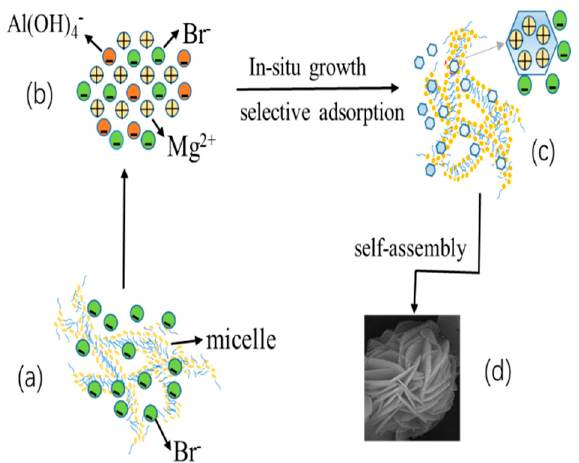
Figure 3. The formation process of hierarchical hydrotalcite ( a ) represents the formation process of surfactant micelles, ( b ) represents the mixing process of mixing metal salt solution and surfactant micelles, ( c ) represents the interaction between hydrotalcite and surfactant micelles, and ( d ) represents the morphology of the multidimensional MgAl-LDH nanoparticles).